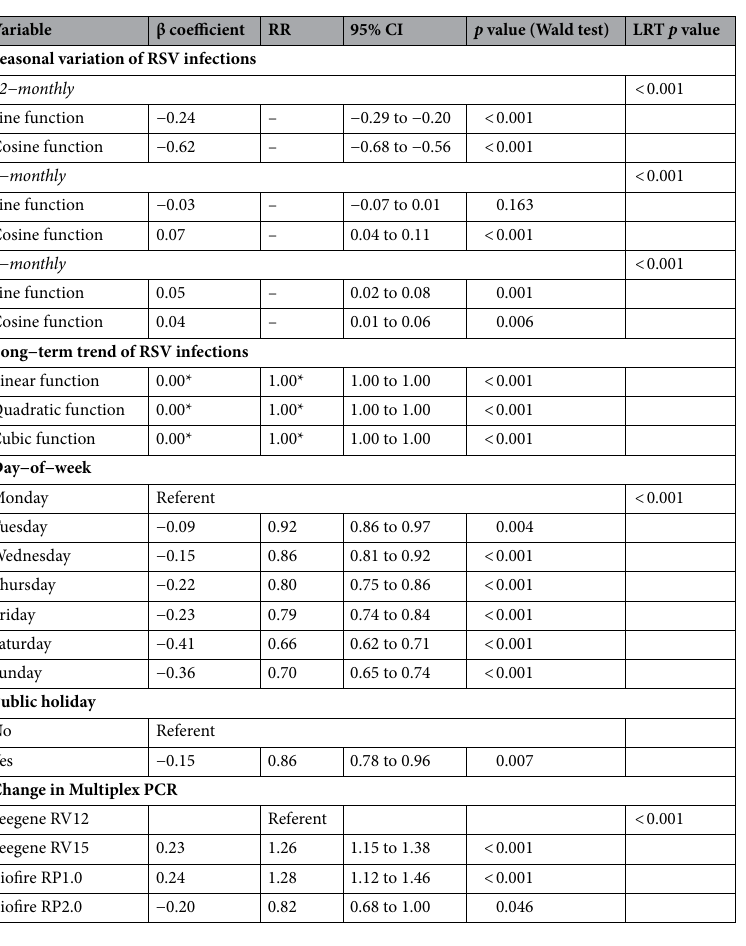
Table 2. Adjusted associations between public holidays and day-of-week with RSV infections in Singapore, 2009–2019. *For the long-term trend of RSV infections, beta coefficients are above 0.00 for the linear and cubic terms, and below 0.00 for the quadratic term. Point estimates are above 1.00 for the linear and cubic terms, and below 1.00 for the quadratic term. LRT Likelihood Ratio Test.